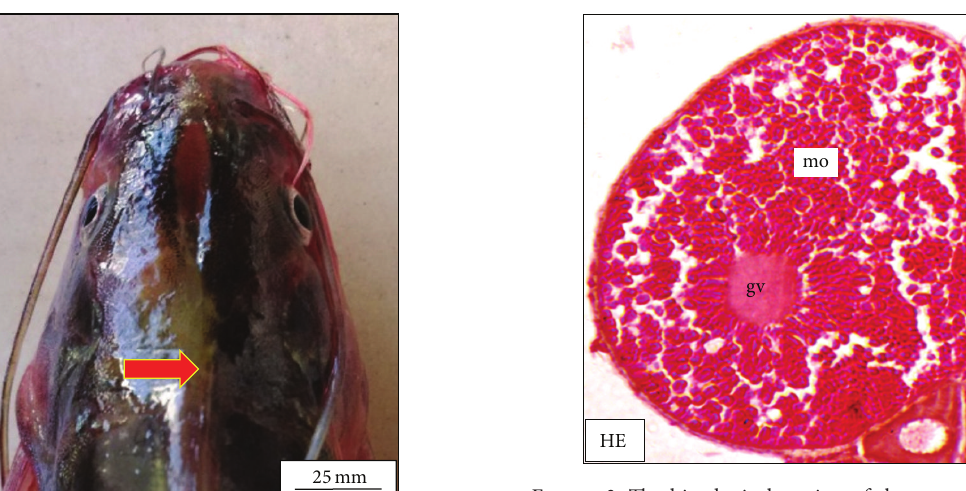
Figure 3: The histological section of the ovary of a mature adult Mystus tengara during the spawning phase (June) revealing the yolk laden mature ovum (mo) with laterally migrating germinal vesicle [HE: Haematoxylin-Eosin